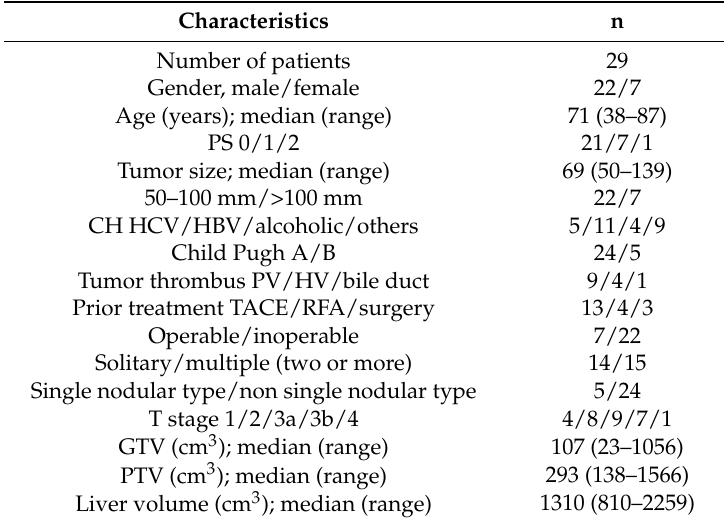
Table 1. Characteristics of the patients and the